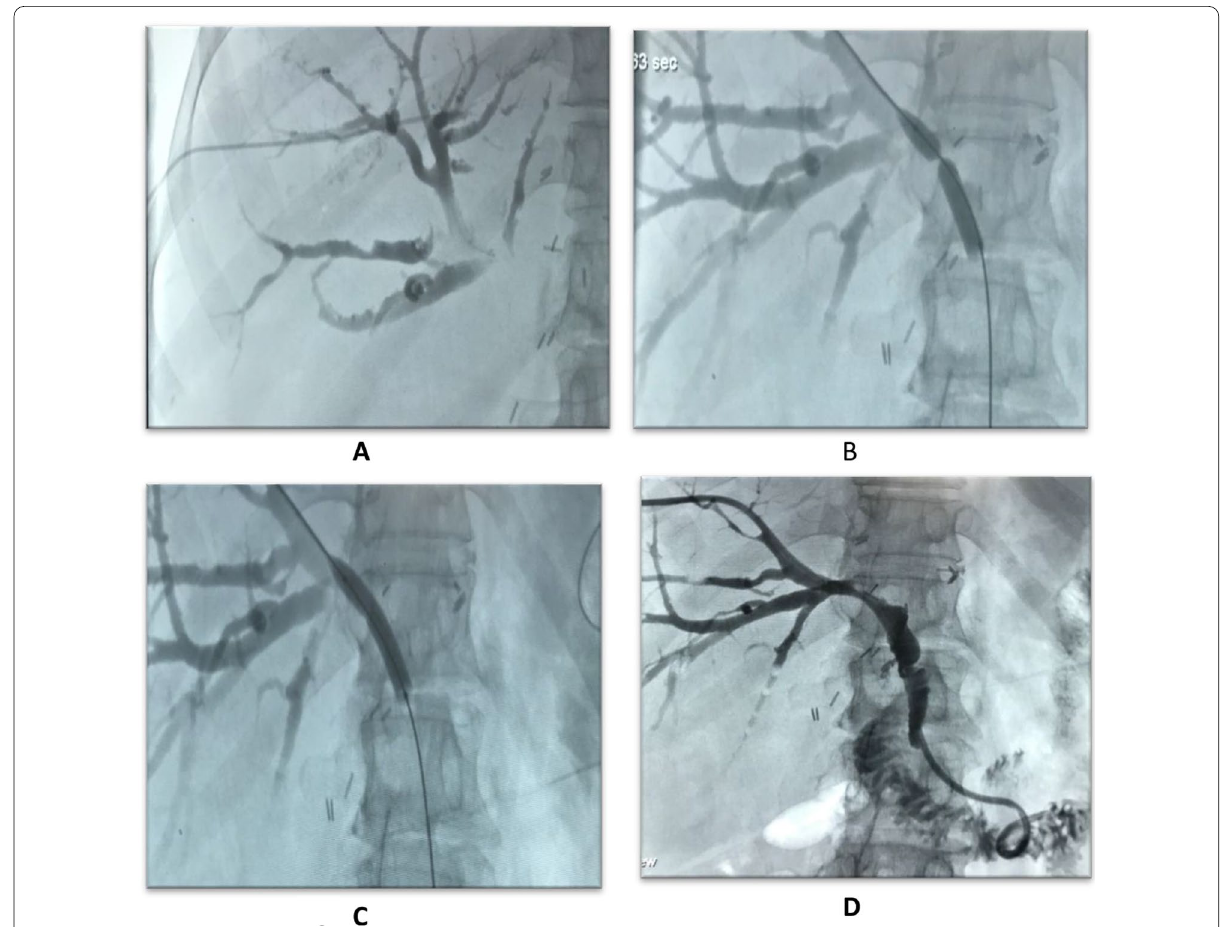
Fig. 16 A A transhepatic insertion of an angiocath with contrast opacification of the biliary radicals. B A hydrophilic wire inserted in the CBD with wasting of the balloon, C The resolved wasting on balloon inflation. D A well‑placed internal/external drain with opacification of the bowel loops denoting proper